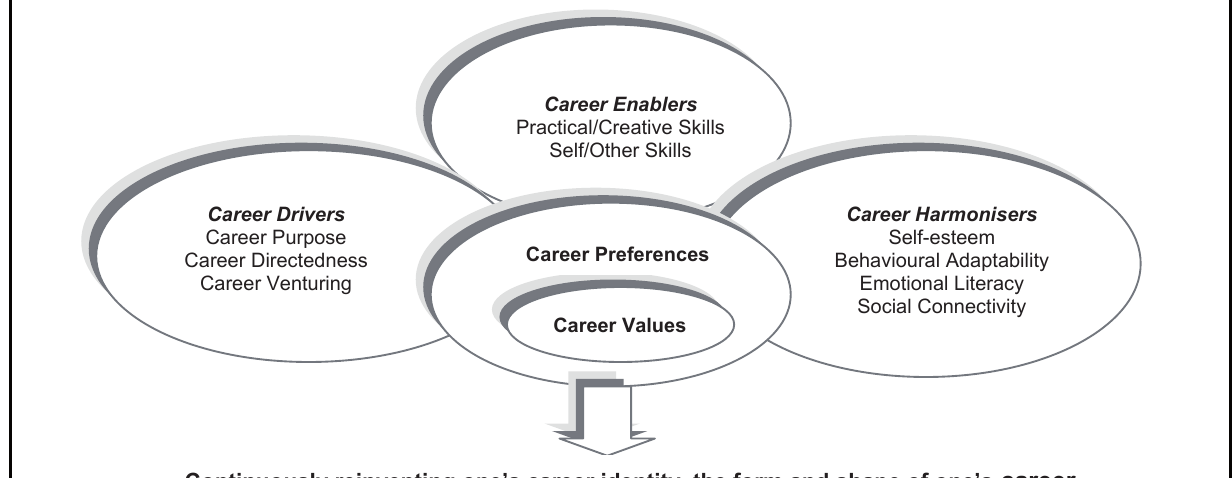
Figure 1 A theoretical framework of the construct psychological career resources (based on Coetzee,